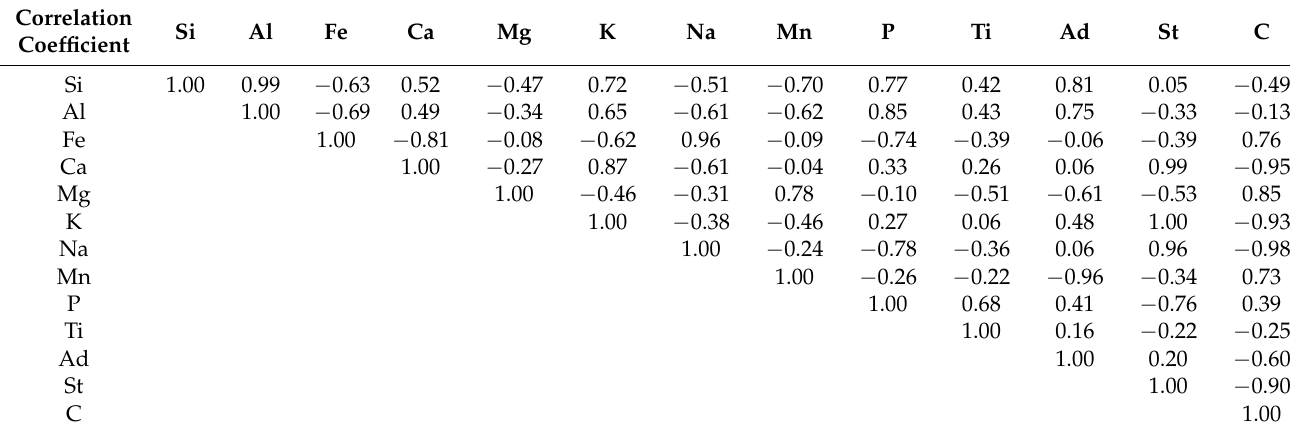
Table 4. Correlation coefficient analysis of major elements of No. 9